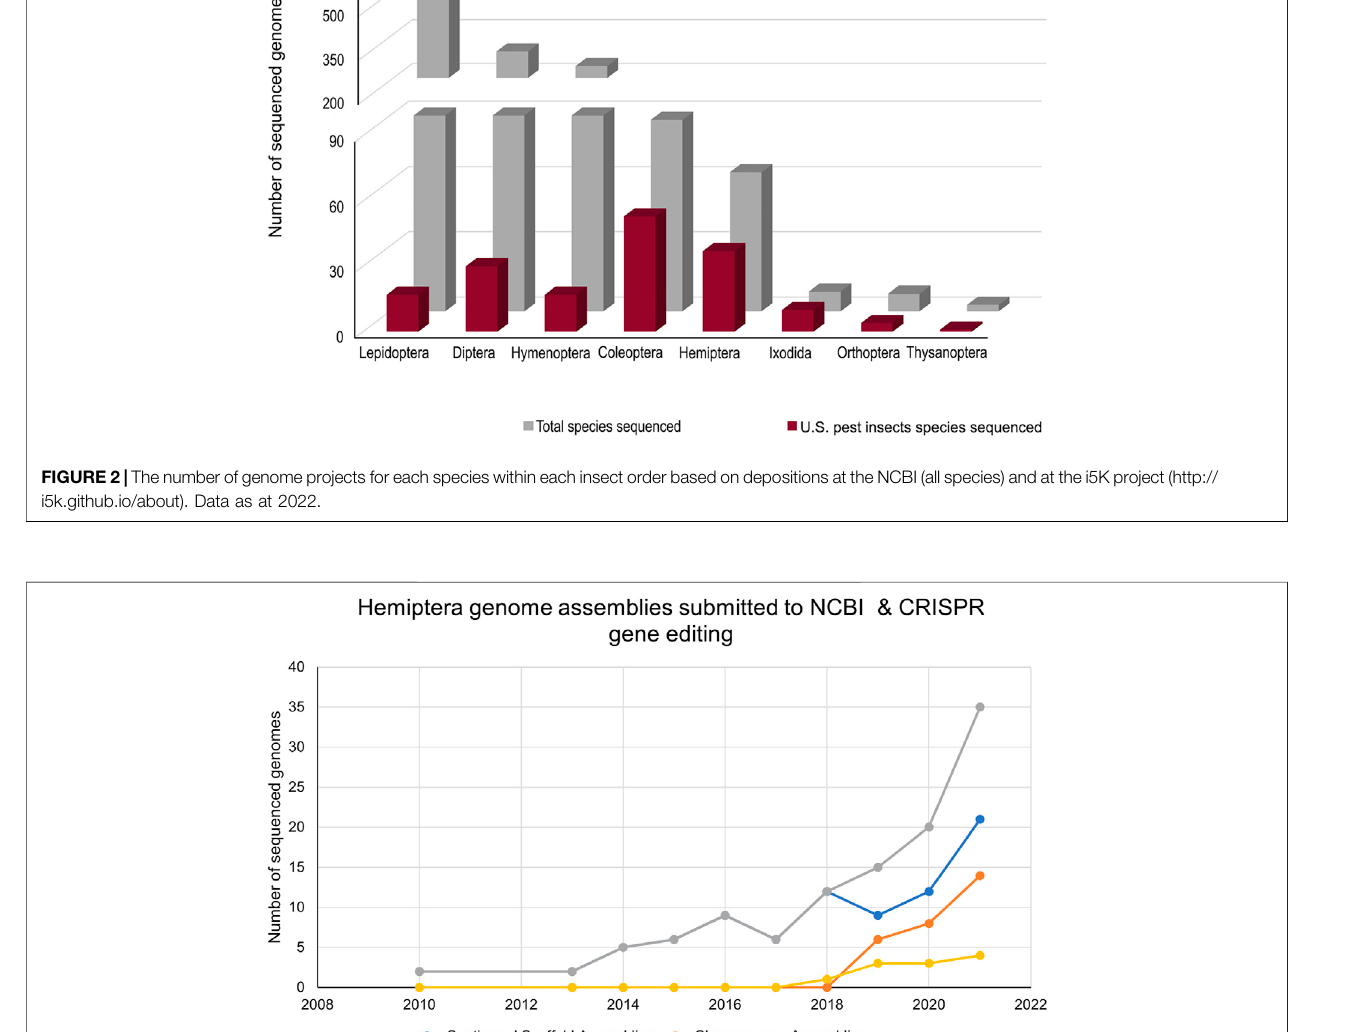
Frontiers in Bioengineering and Biotechnology |